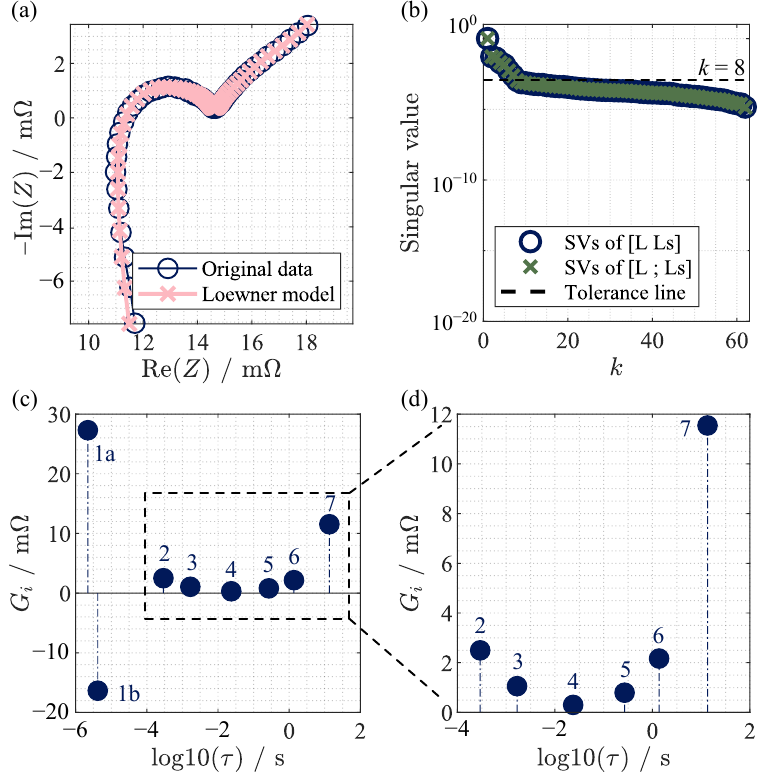
Figure 6. Nyquist plot ( a ), SVD ( b ), distribution of gains ( d ), and analyzed processes of the distribu- tion of gains ( c ) of the measurement